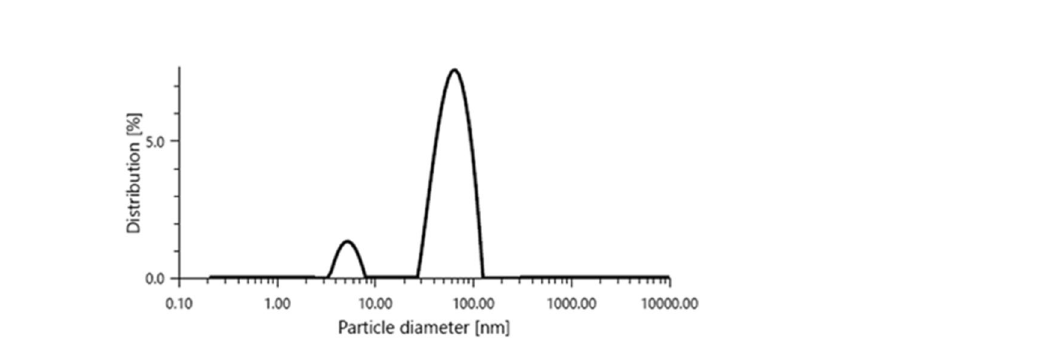
Figure 3. DLS graph showing size distribution of the